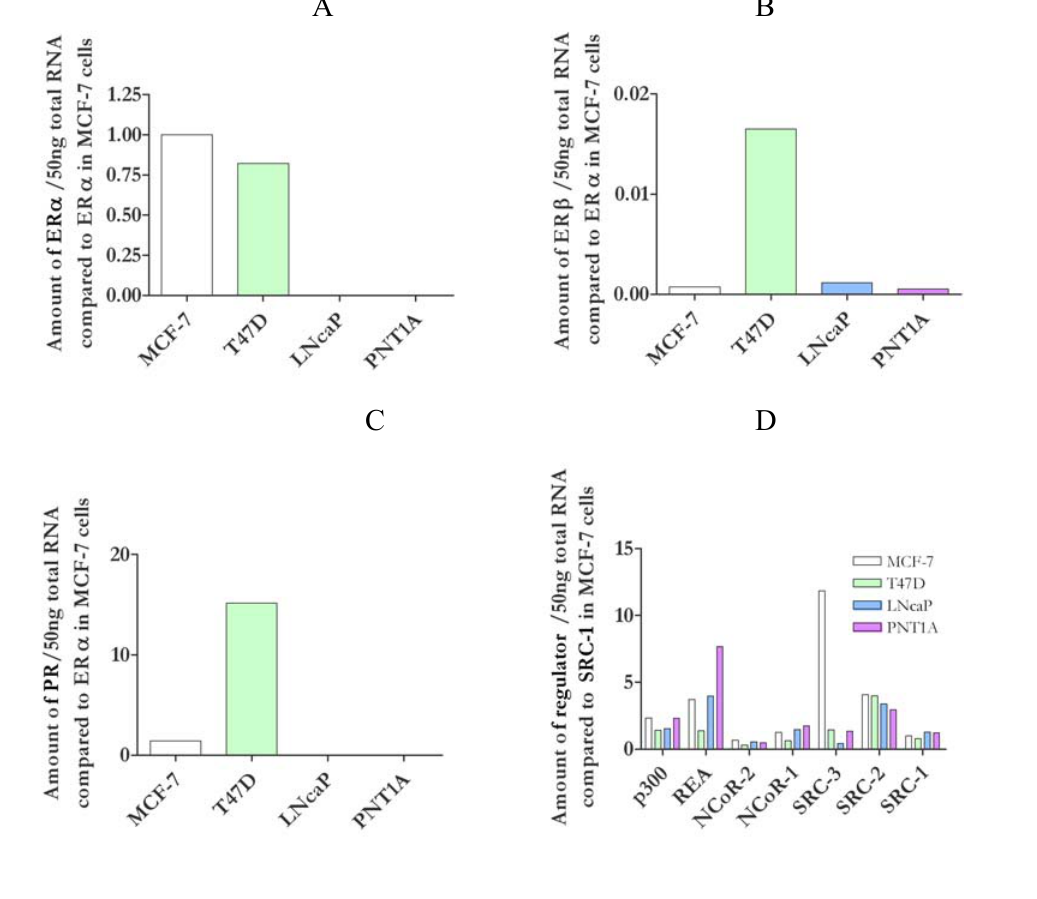
Figure 1. Expression levels of steroid receptor and co-regulator differ between cells lines. Amount of receptor mRNA present in 50ng of total RNA from each cell line measured by qRT-PCR. All values for ER α (A), ER β (B) and PR (C) were expressed as ratios of ER α from MCF-7 cells. Amounts of coregulator mRNA (p300, REA, NCoR-2, SRC-3, SRC-2 and SRC-1) were expressed as a ratio of SRC-1 in MCF-7 cells (D). Each experiment was performed in duplicate and repeated three